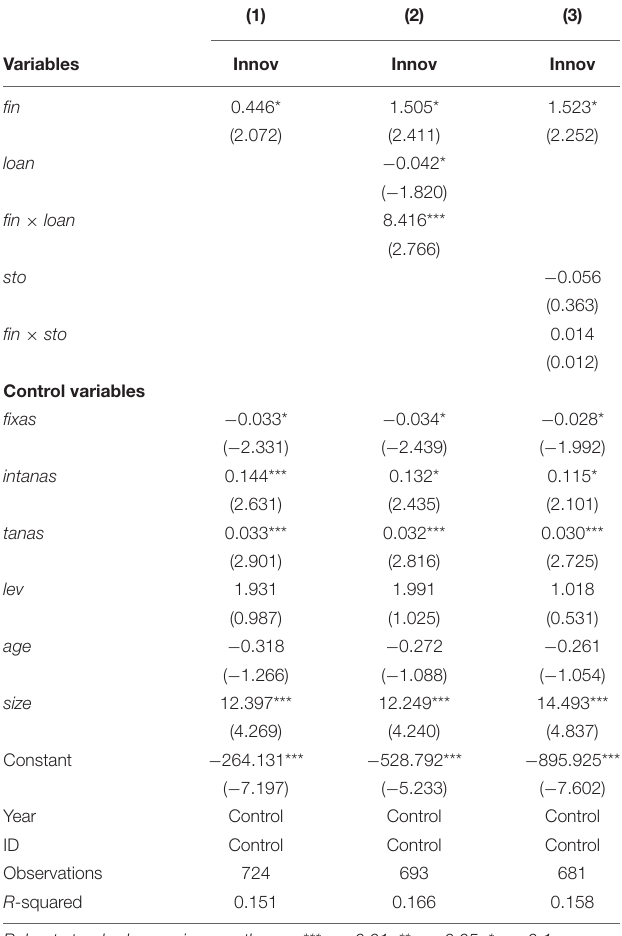
TABLE 3 | Digital financial inclusion and innovation performance: primary results.